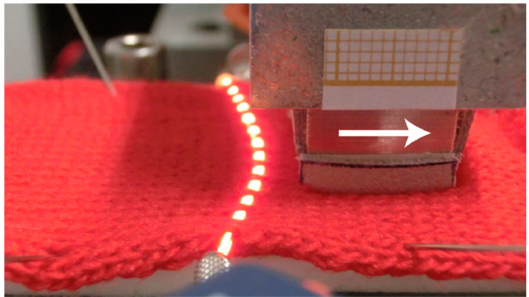
Figure 14. Deflection of the POF at the back of the slider in the single jersey fabric. The direction of movement is indicated by the